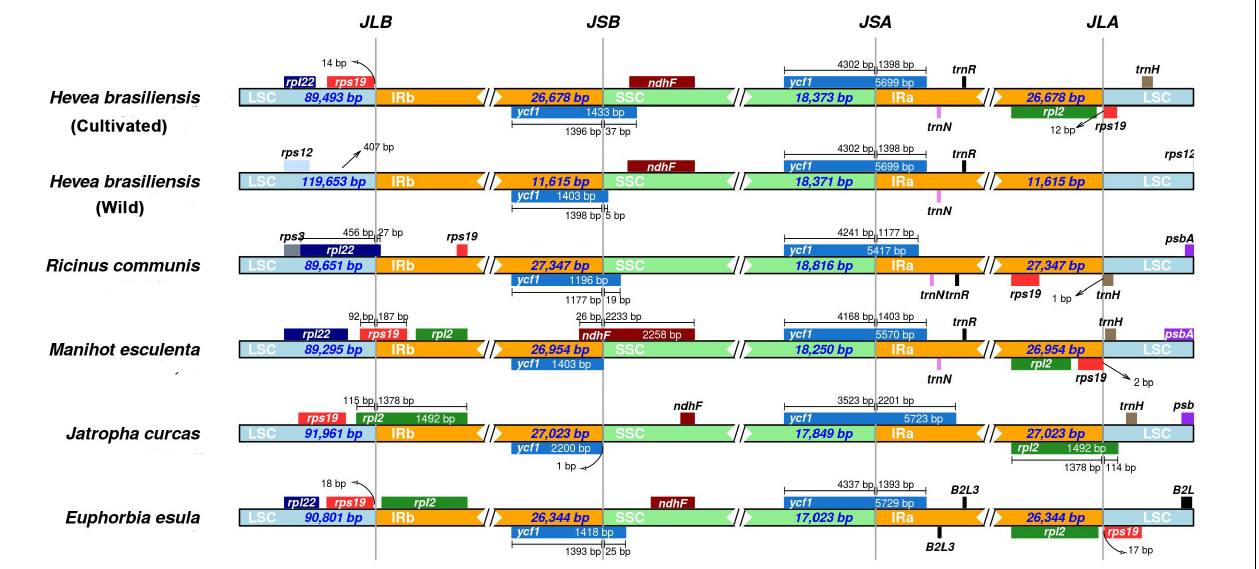
FIGURE 4 | Comparison of border distances between adjacent genes and junctions of LSC, SSC, and two IR regions among chloroplast genomes of the five spurge